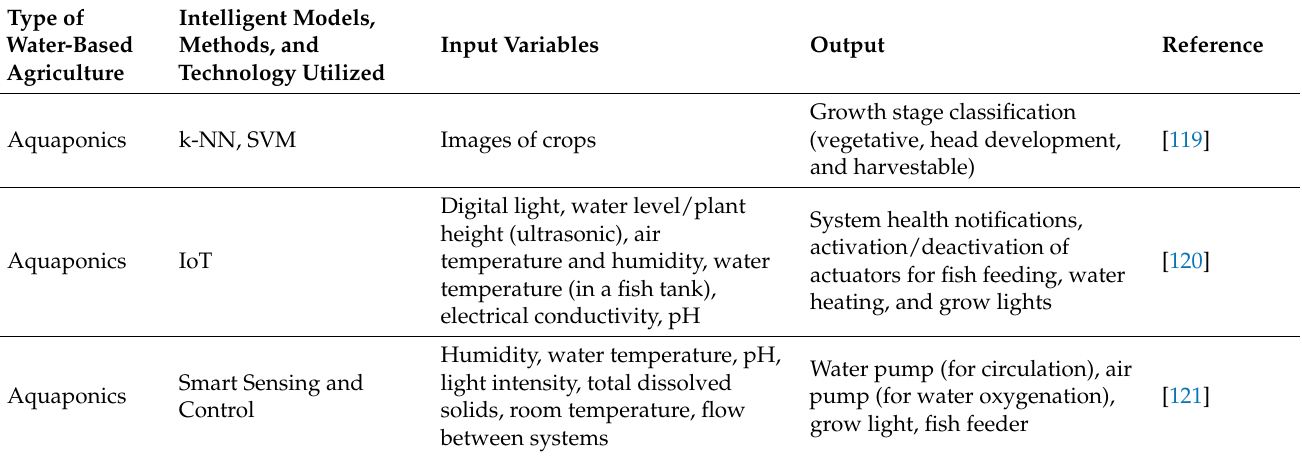
Table 6. Intelligent models, methods and technology to monitor and predict plant growth in hydro- ponic and aquaponic agriculture